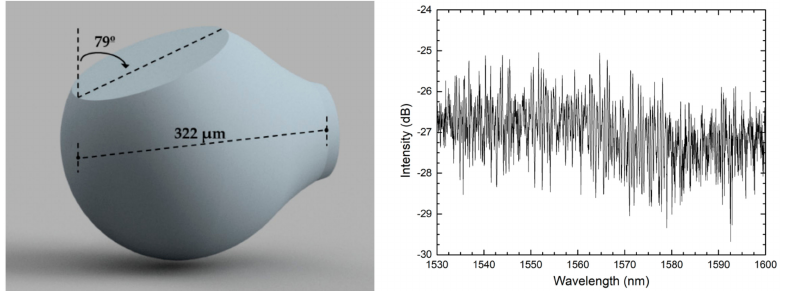
Figure 2. Schematic of the focused ion beam cleaved microsphere and its reflection spectrum. Reproduced withpermission from [8]. IEEE Photonics Technology Letters,